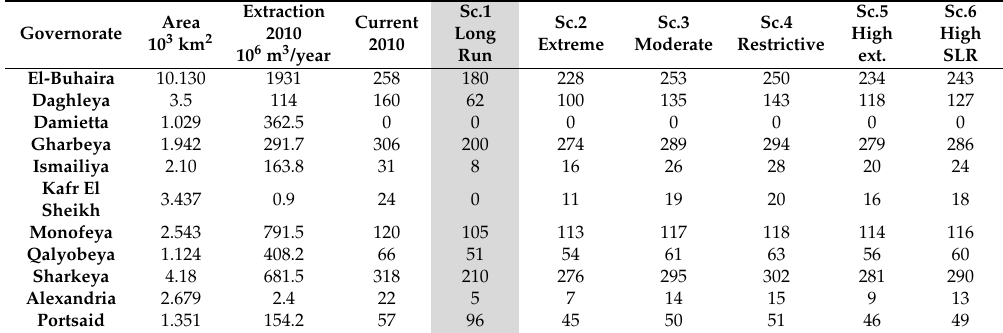
Table 3. The fresh groundwater volume in 10 9 m 3 with respect to different scenarios in all governorates of the Nile Delta.